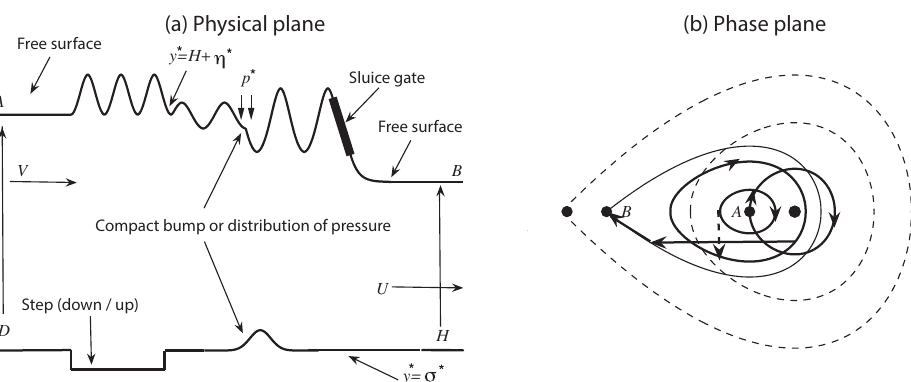
Figure 2. Sketch of a typical flow problem in both the physical and phase plane [62]. ( a ) Sketch of flow in the physical plane, ( x ∗ , y ∗ ) . The free surface and channel bed topography are described by y ∗ ( x ∗ ) = H + η ∗ ( x ∗ ) and y ∗ ( x ∗ ) = σ ∗ ( x ∗ ) . The flow is assumed to approach a uniform stream as x ∗ → ∞ with η ∗ ( x ∗ ) → 0 and σ ∗ ( x ∗ ) → 0. Without loss of generality, the location of x ∗ = 0 is usually chosen to be at the midpoint of one of the disturbances. ( b ) Sketch of flow in the phase plane, ( η ∗ , η ∗ x ∗ ) . The origin in the phase plane is located at point